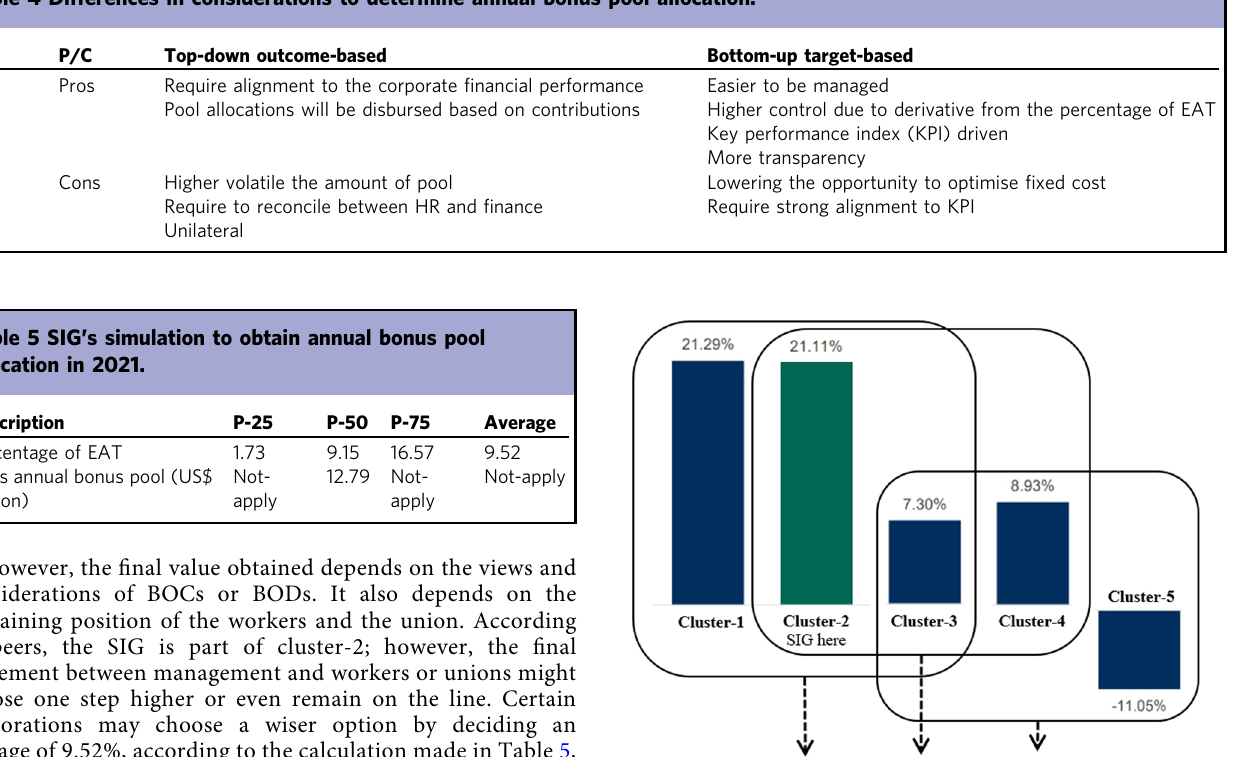
Fig. 6 The two types of SIG strategies. The two different strategies to be carefully considered. The SIG has enacted both of techniques and the best piece of application is the bottom-up Table 4 Differences in considerations to determine annual bonus pool allocation.